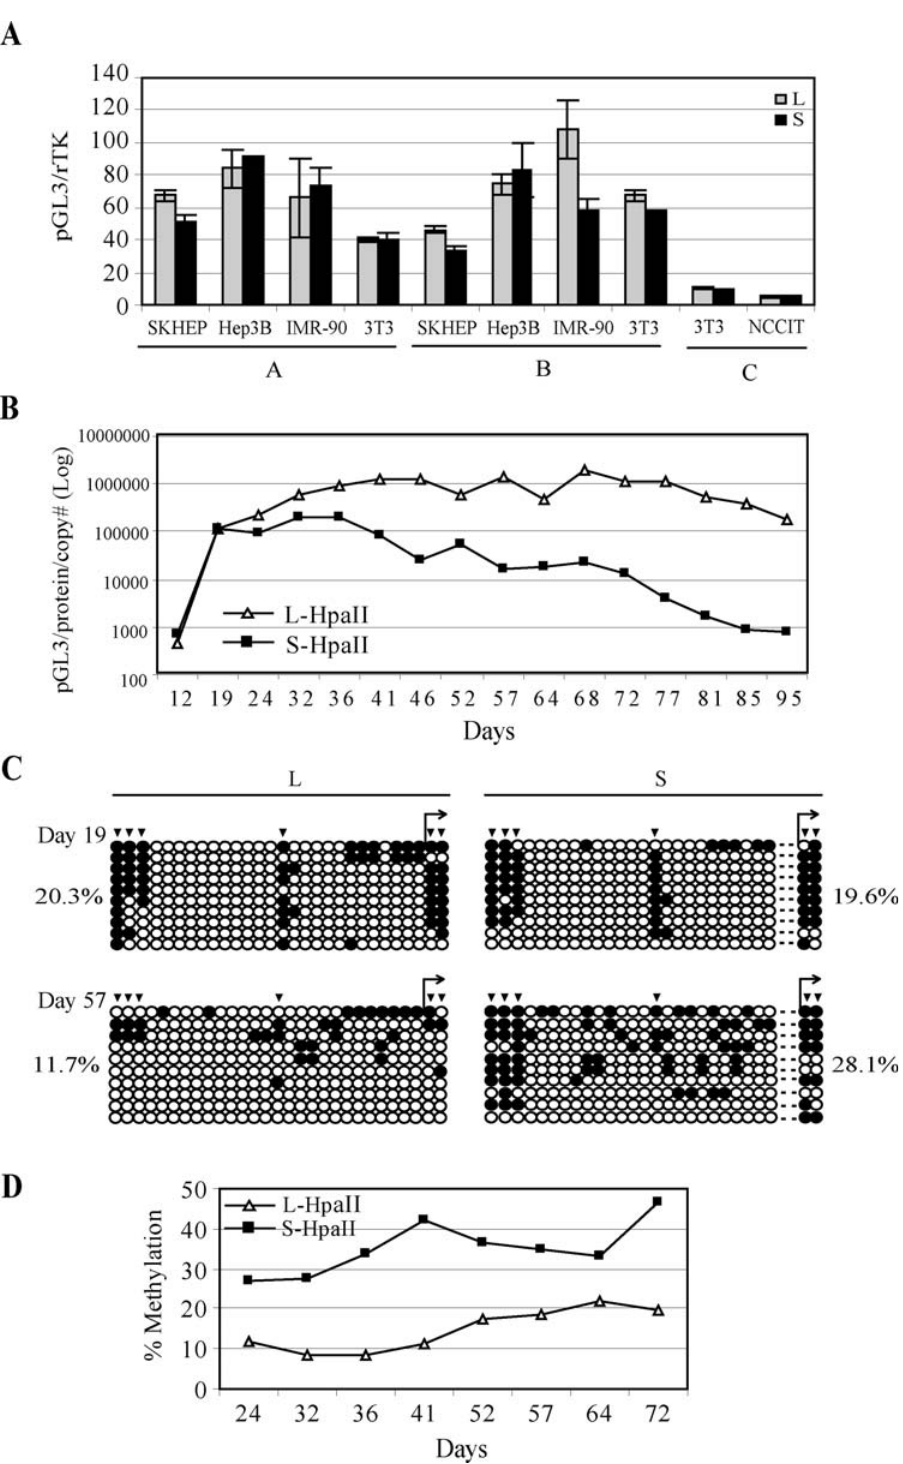
Figure 4. Induction of Hypermethylation and Silencing of the RIL Short Allele in Vitro. (A) Summary of transient allele-specific RIL/reporter gene expression in 4 cell lines. , 0.2 KB (A), , 0.6 KB (B) and , 1.1 KB (C) RIL L and S promoter fragments were cloned upstream of pGL3 luciferase and transiently cotransfected with renilla thymidine kinase as a transfection control into the indicated cell lines in 6-well plates. Cells were harvested at 48 hrs and luciferase activities were analyzed. Luciferase/renilla ratios were plotted on the Y-axis. Transfections were performed in triplicates, and standard error bars for each experiment are shown on the graph. (B) Expression of stably transfected HpaII-seeded constructs. Long and short RIL allele-specific constructs (construct B, , 0.6 KB) were seeded with HpaII methylase, stably cotransfected with pcDNA3.1 into NIH3T3 cells, selected in neomycin and pooled clones monitored for the indicated time period. Notice initial equal levels of expression, followed by maintenance of the long allele construct expression and rapid decline in expression of the short allele construct. (C) Bisulfite sequencing results for allele-specific seeded constructs. The methylation status of the transfected allele-specific constructs was analyzed by bisulfite sequencing at indicated time points, using